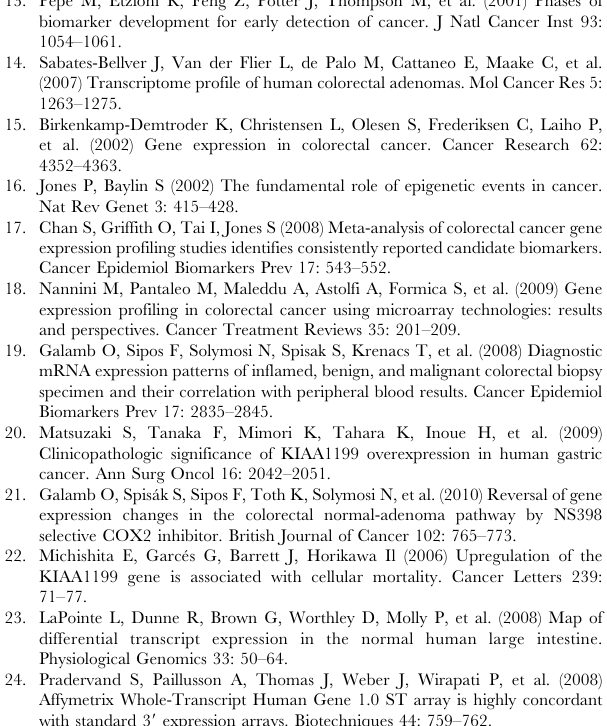
Table S1 Probesets identified to be at least two-fold up-regulated in colorectal cancer (n= 161) relative to adenoma (n =29) tissue specimens. Table S2 Probesets identified to be at least two-fold down- regulated in colorectal cancer (n =161) relative to adenoma (n =29) tissue specimens. Table S3 Genes identified to be at least two-fold differentially expressed in colorectal neoplastic (29 adenomas + 161 cancers) relative to non-neoplastic (222 normals + 42 IBDs) tissue specimens. Table S4 Discovery Probesets hypothesized to be switched-on in colorectal neoplastic tissues relative to non-neoplastic tissues. Table S5 Discovery Probesets hypothesized to be switched-off in colorectal neoplastic tissues relative to non-neoplastic tissues.